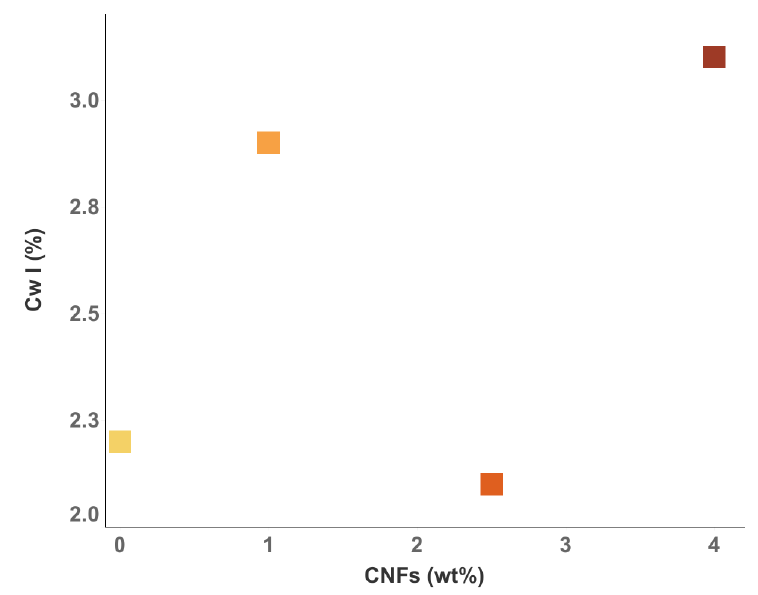
Figure 6. Content of c I water population as a function of CNF wt% (Gradient from yellow to dark W red refers to CNFs amount).